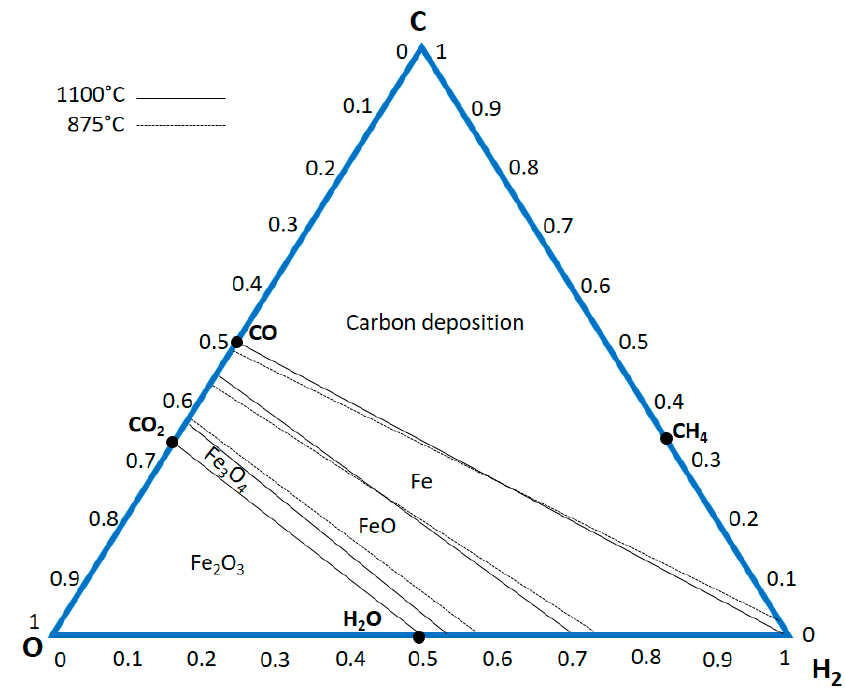
Figure 12. Equilibrium diagram with phases and gas compositions at room pressure.